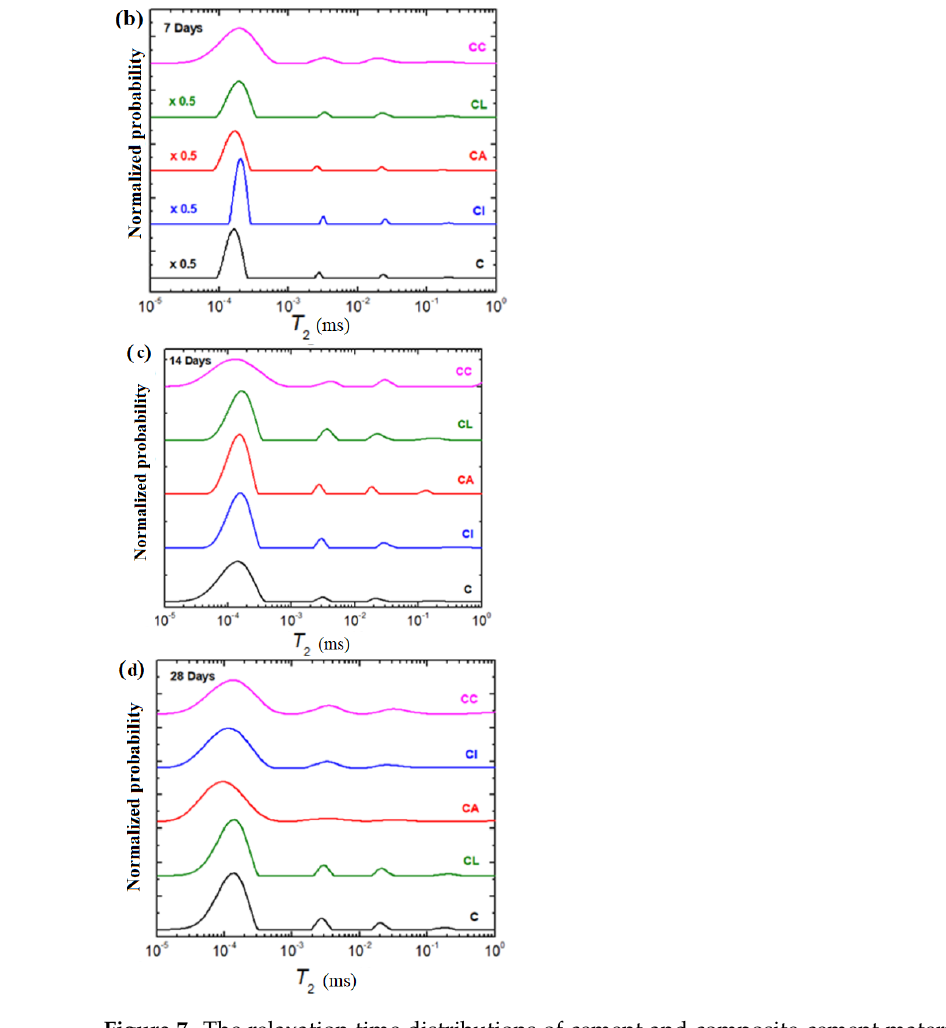
Figure 7. The relaxation time distributions of cement and composite-cement materials (CL: Lead composite-cement, CI: Iron composite-cement, CA: Ash composite-cement, CC: Cash iron composite-cement) performed at ( a ) 3 days, ( b ) 7 days, ( c ) 14 days, and ( d ) 28 days after their preparation.